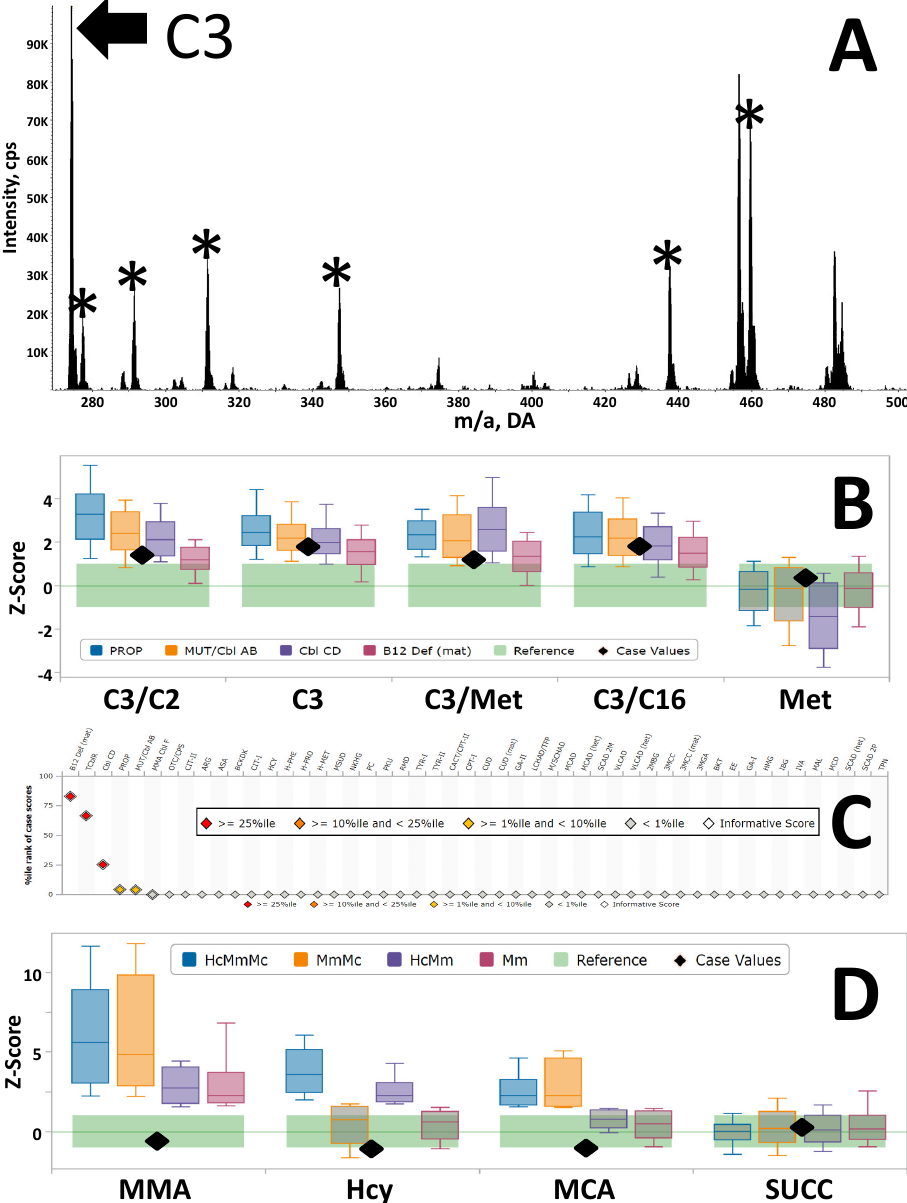
Figure 2. Panel ( A ) Acylcarnitine profile of a case with elevated C3 as first tier result, p85 profile of butyl-ester species. *, Internal standards [18]. Panel ( B ) Acylcarnitine profile of a case with elevated C3 as first tier result, p85 profile of butyl-ester species. *, Internal standards [18]. Panel ( C ) CLIR post-analytical tool “All Conditions Tool”. Color coding of scores is according to the embedded legend. Y-axis is the %ile rank of case scores (likelihood of disease), conditions are sorted highest to lowest from the left. Panel ( D ) CLIR productivity tool “Plot by Multiple Conditions” for the four markers measured by the second tier test (2TT). Black diamonds arranged as in Panel B. Concentrations were as follows: MMA 0.3 nmol / mL (test catalog reporting cuto ff < 5); tHcy 0.9 nmol / mL ( < 15); MCA 0.1 nmol /